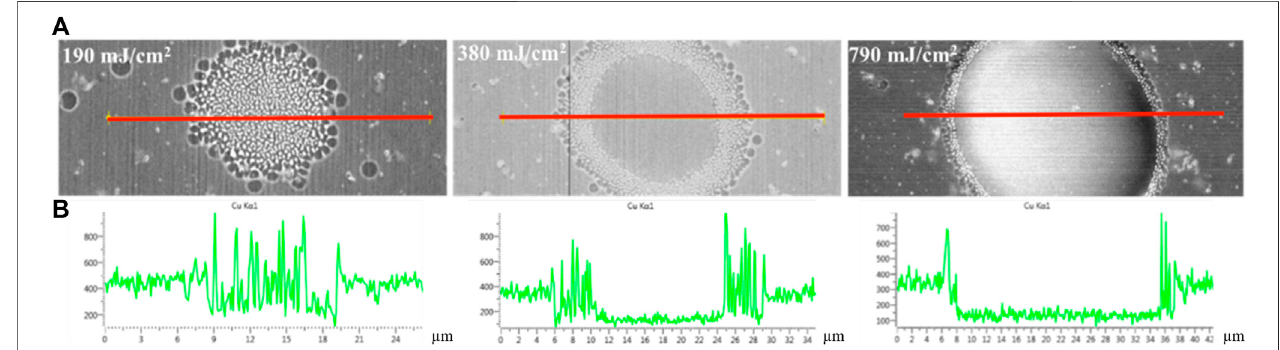
FIGURE 3 | (A) SEM-line EDS images of structures produced using laser fl uence of 190 mJ/cm 2 , 380 mJ/cm 2 , and 790 mJ/cm 2 , respectively. (B) Selected time- resolved images with 60 ns delayed under different laser intensities.